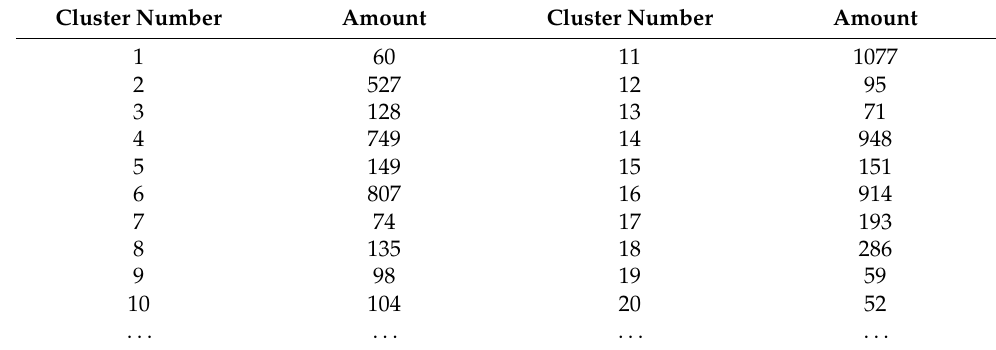
Table 4. Clustering results.